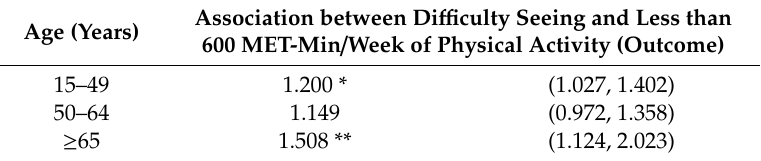
Table 3. Association of di ffi culty seeing and physical activity (outcome) by age groups estimated with multivariable logistic regression. ( n =